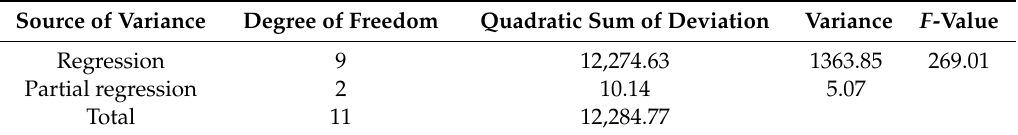
Table 4. Variance Analysis of Linear Regression Equation Composed of Operational Parameters.